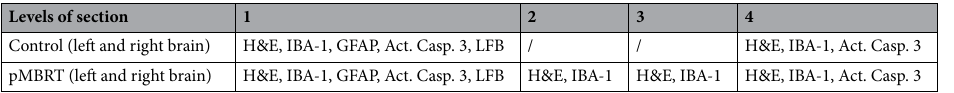
Table 1. Histopathological assessment. Histopathological analyses were performed in each section from each region for the control (2 regions separated by at least 600 µm) and irradiated (4 regions separated by at least 200 µm) groups. HE (haematoxylin and eosin) staining to evaluate the lesions. Iba-1 (ionized calcium-binding adapter molecule 1; marker of microglial cells), GFAP (glial fibrillary acidic protein; marker of astrocytes), Act. Casp. 3 (activated caspase 3; marker of apoptosis), and LFB (luxol fast blue; myelin)